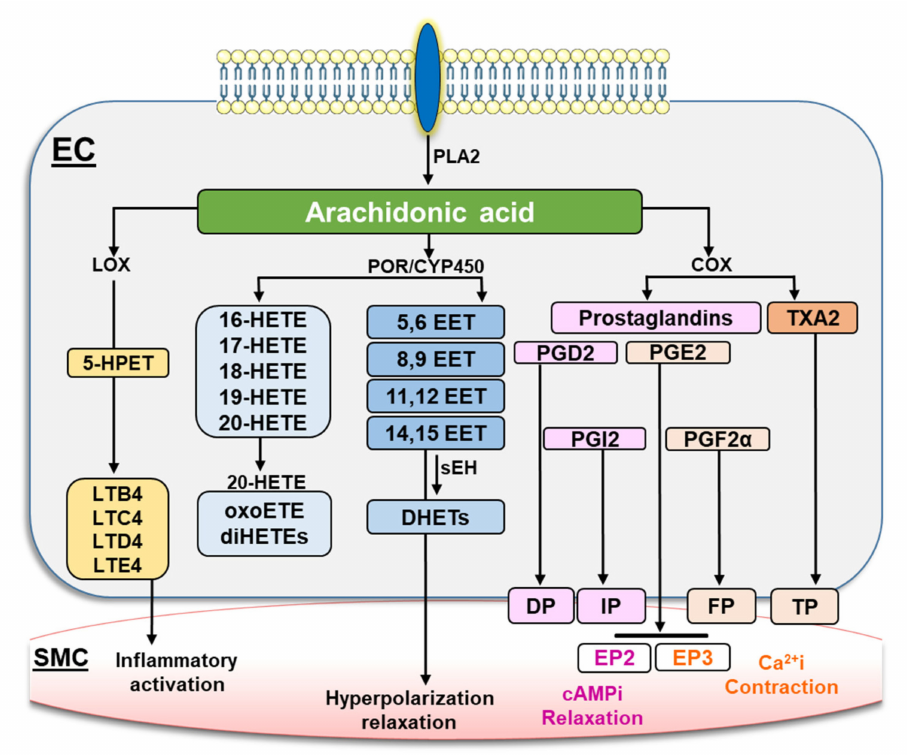
Figure 1. Metabolic pathways of arachidonic acid. Phospholipase A2 (PLA2) hydrolyzes arachi- donic acid (AA) from membrane-bound phospholipids. The cyclooxygenase enzymes (COX) me- tabolize AA into different prostanoids such as prostaglandin D2 (PGD2), prostacyclin (PGI2), prostaglandin E2 (PGE2), prostaglandin F2 α (PGF2 α ) and thromboxane A2 (TXA2). These prostanoids act on their respective preferential receptor, DP, IP, EP, FP and TP, leading to control of ves- sel tone. AA can also be metabolized through the cytochrome P450 reductase (POR)/CYP450 system leading to production of 5,6-; 8,9-; 11,12-; and 14,15-epoxyeicosatrienoic acids (EETs) as well as several biologically active hydroxyeicosatetraenoic acids (HETEs). The EETs can be further catabolized to the less-active dihydroxyeicosatrienoic acid (DHET) through the soluble epoxide hydrolase enzyme (sEH). The lipoxygenases (LOX) metabolize AA into leukotrienes (LTB4, LTC4, LTD4 and LTE4) through reactions that can also involve the formation of an intermediate: 5(S)-Hydroperoxyeicosatetraenoic acid